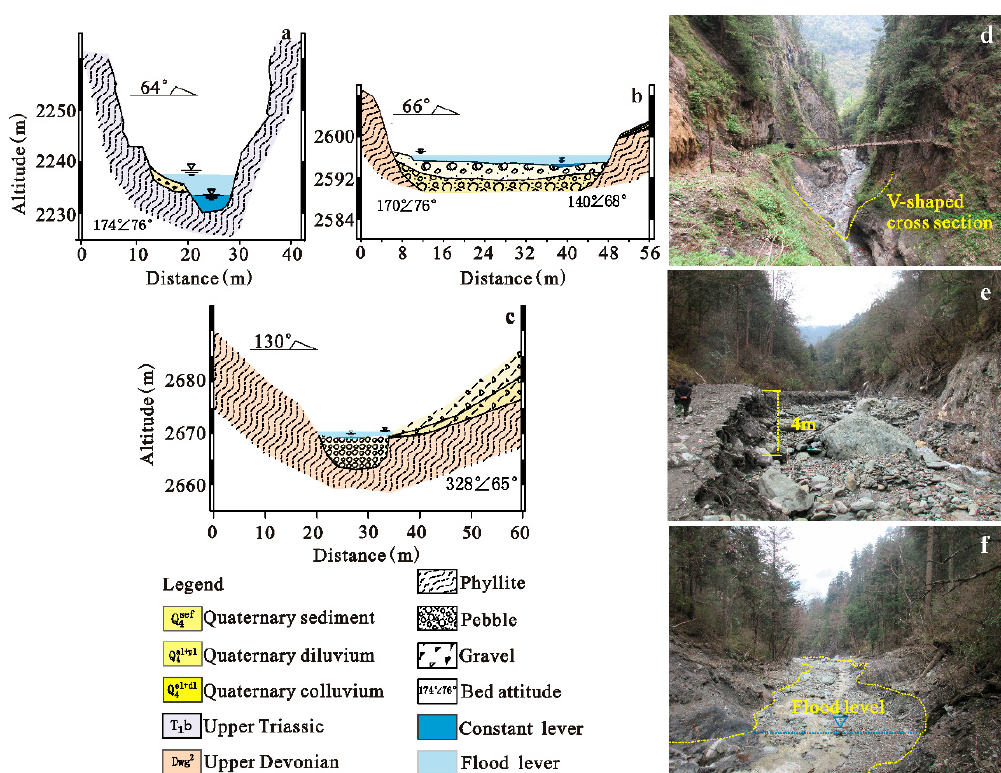
Figure 5. Morphological characteristics of Xiongmao Gully. ( a , d ) A cross-section of transition zone in which the gully is narrow with exposed bed rock slopes; ( b , e ) a typical cross-section of the accumulation zone in which the gully is wide with large amounts of solid material; ( c ) the erosion of slope deposits in the upstream area; ( f ) nearly no solid materials in the upstream gully.